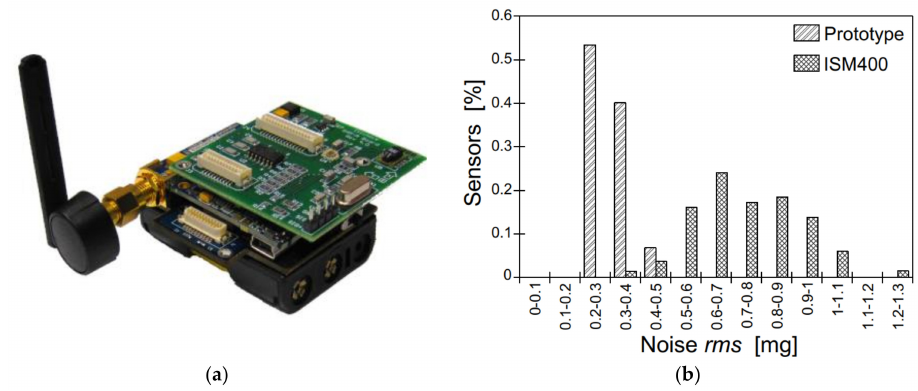
Figure 3. Noise level assessment: ( a ) detail for the wireless MEMS designed by the University of Illionis, Urbana-Champaign, and ( b ) noise level comparisons ( Z -axis), as obtained from laboratory testing and the literature